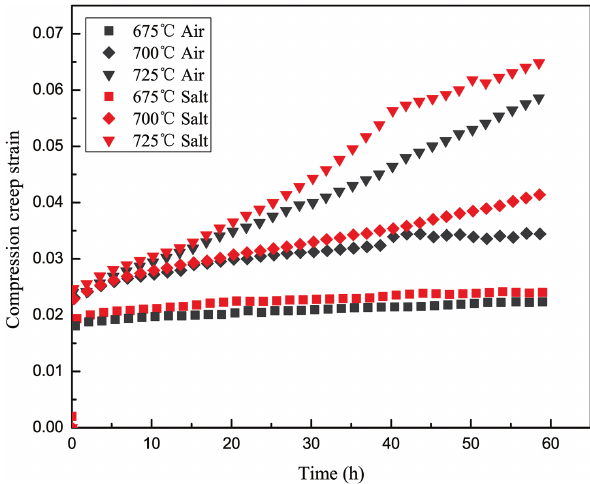
Figure 2: Compression creep curves of bare specimens and speci- mens in hot corrosive environment at different